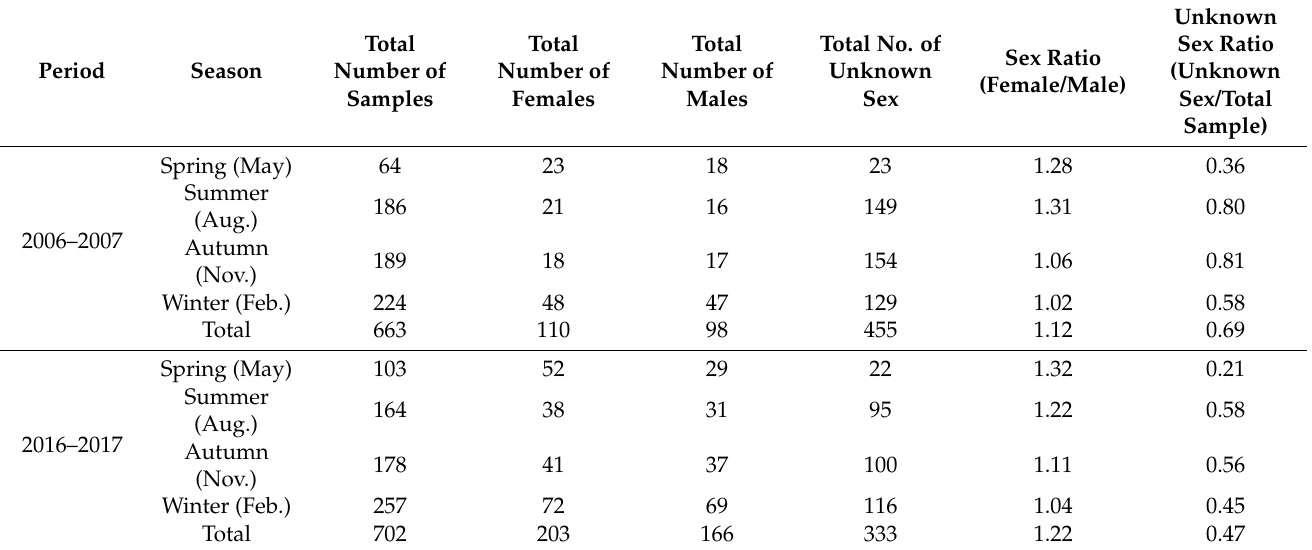
Table 2. Sex ratio and unknown sex ratio in two periods.